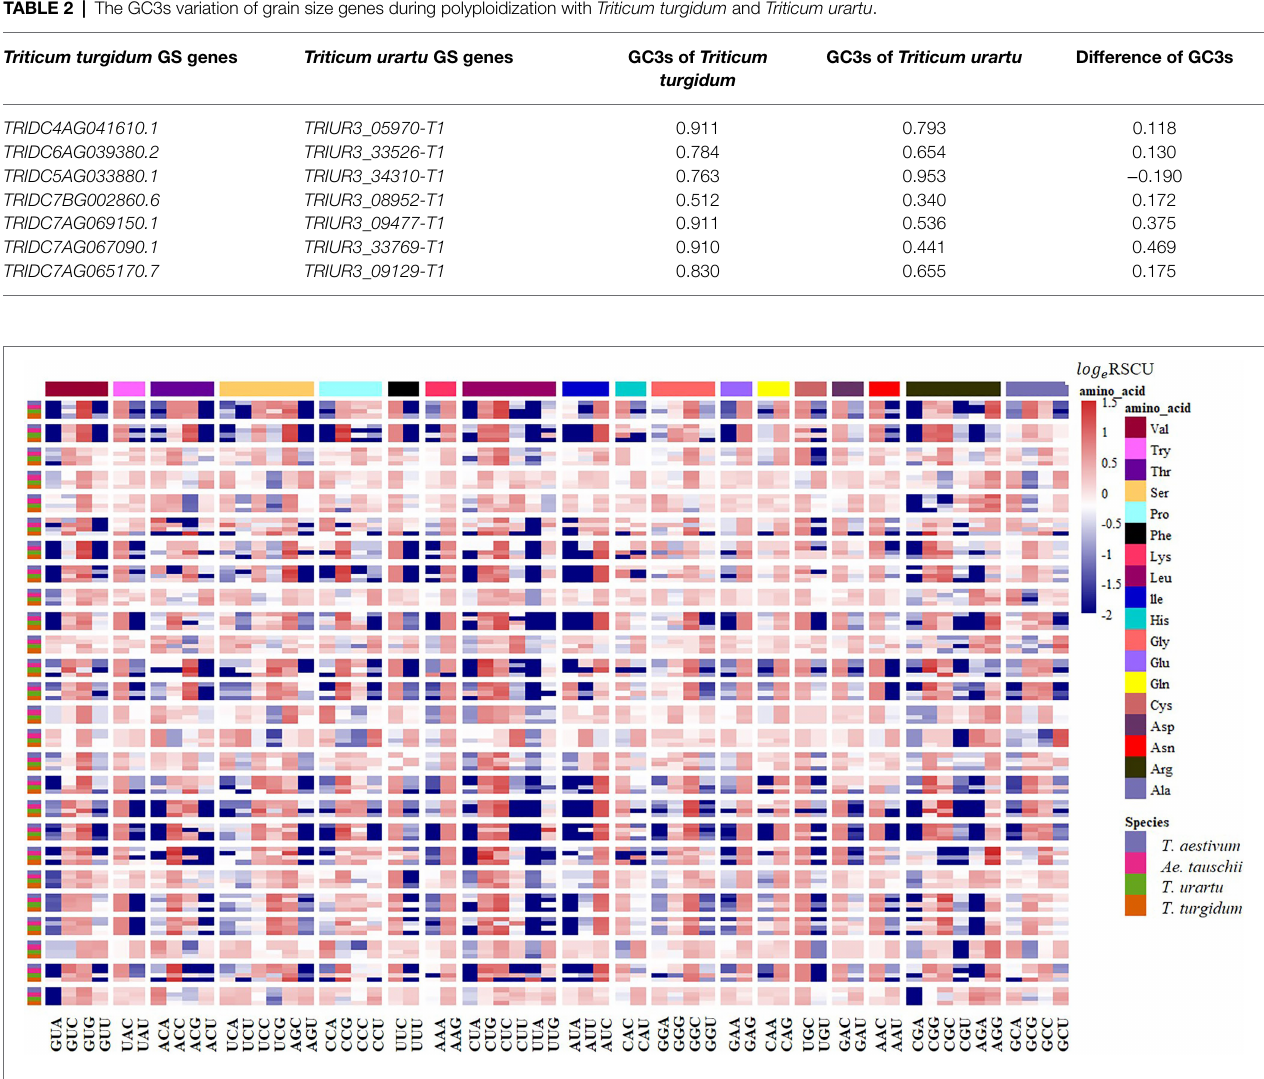
FIGURE 7 | RSCU analysis showing synonymous codon usage preference of the CCT gene families in common wheat and its ancestor species. Columns correspond to the 59 nondegenerate, non-stop codons. Rows correspond to special family genes in the four species. Blue cells indicate low bias codons and red cells indicate high bias